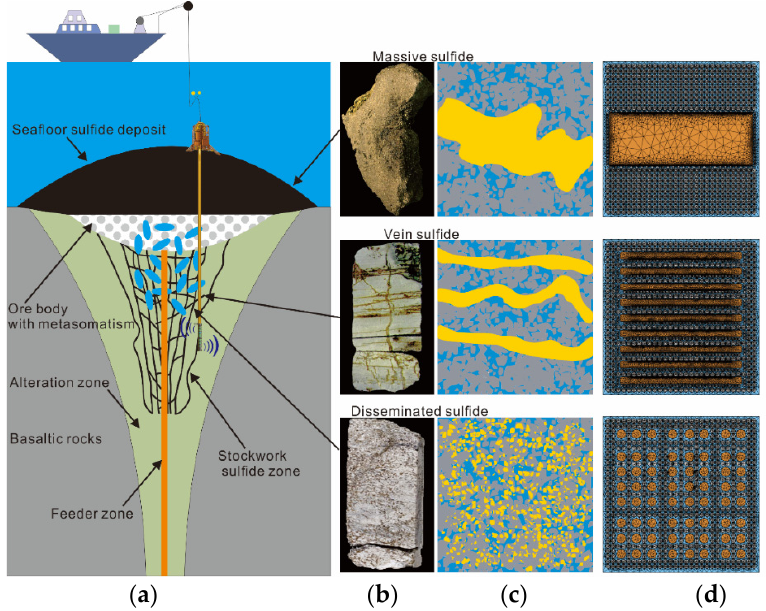
Figure 1. Representative mineralization structures in a seafloor polymetallic sulfide deposit. ( a ) Cross-sectional view of the distribution of the mineralized zones of a seafloor polymetallic sulfide deposit, modified from Fouquet et al. (2013) [28]. ( b ) Photographs of drill cores from seafloor sulfide deposits corresponding to the three kinds of mineralization. The photographs of the drill cores are from Marques et al. (2007) [29], Zierenberg et al. (1998) [30], and Anderson et al. (2019) [31]. ( c ) Schematic of three representative mineralized sulfide-bearing rocks. ( d ) Numerical models of seafloor sulfide-bearing rocks with various mineralized structures together with the finite-element mesh for the 2D numerical simulations. The grey circles denote basalt, the yellow zones denote metal sulfides, and the blue zones denote NaCl solution with a salinity close to that of seawater.